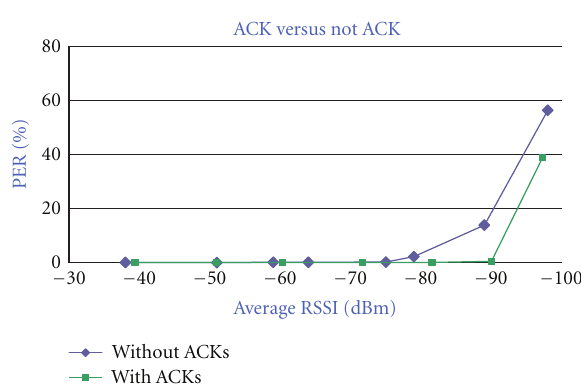
Figure 18: Representation of wireless link degradation in terms of percentage of PER, with or without use of